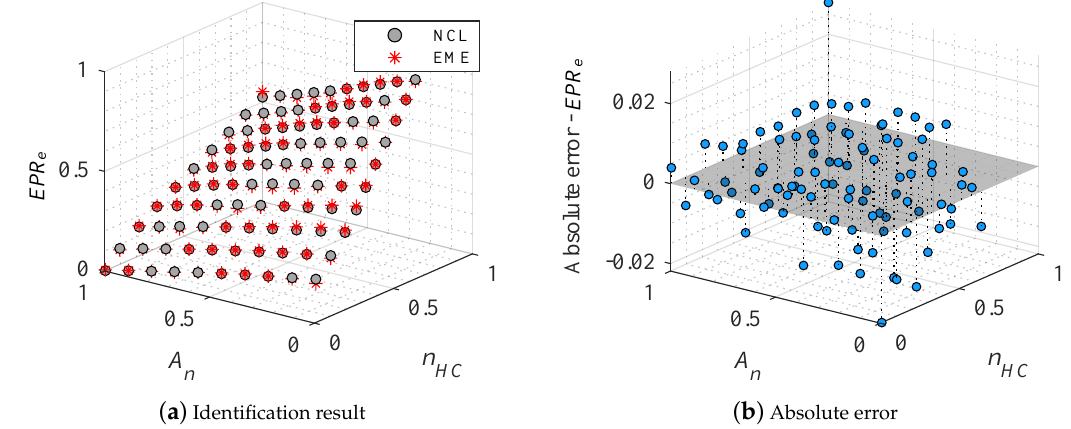
Figure 6. The identification result and absolute error of the EM ( α = [ n HC , A n ]) EPR e .